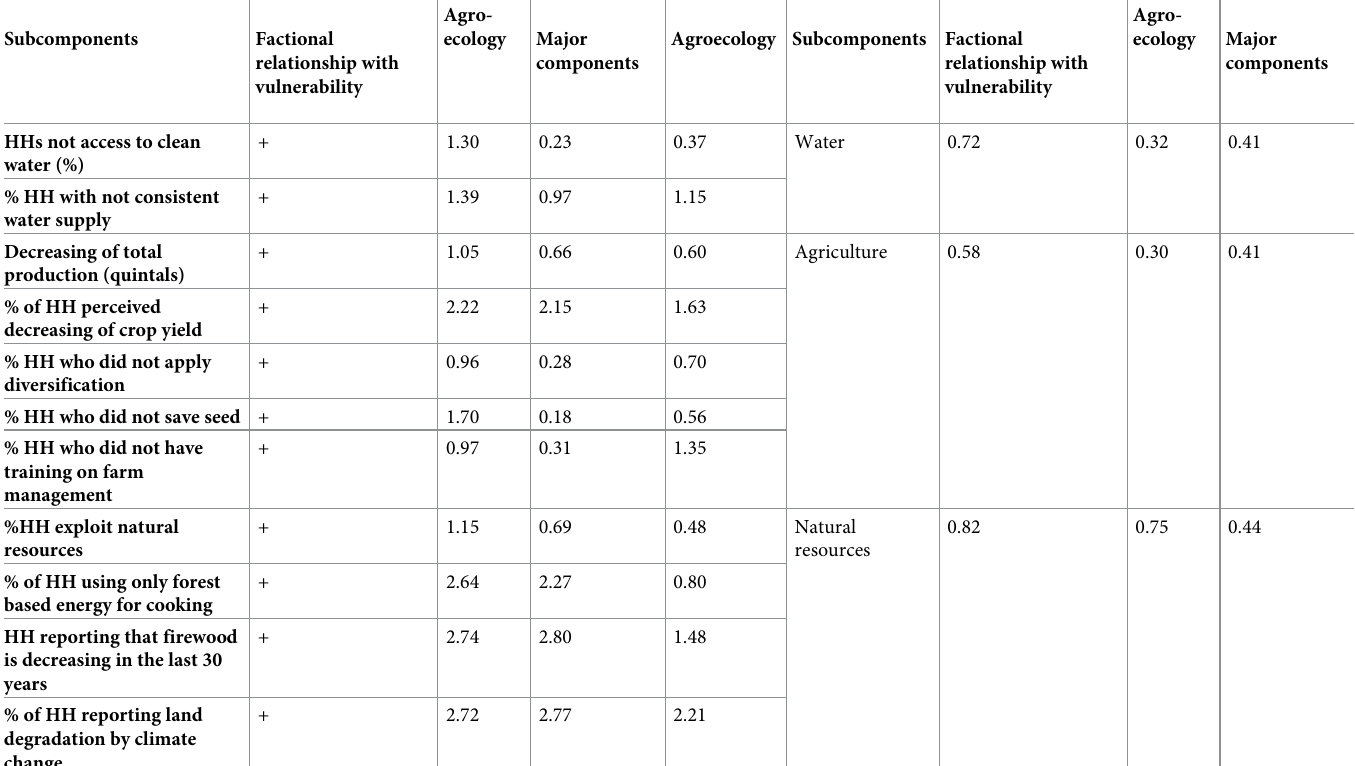
Table 6. Major components’ scores, indicator index and weighted average of Sensitivity